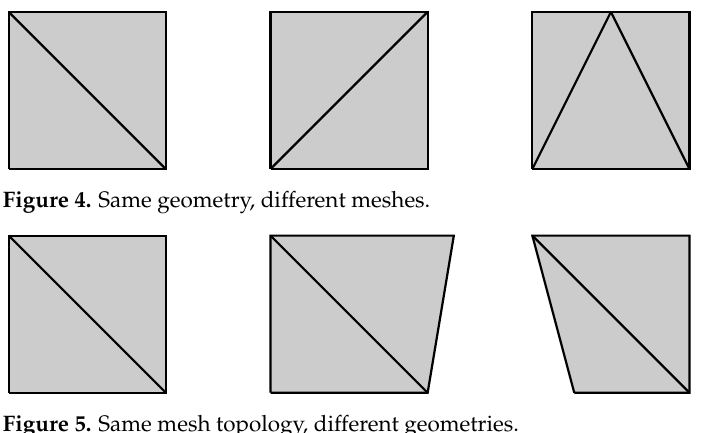
Figure 3. Relative error of the derivative computed by the finite-difference.